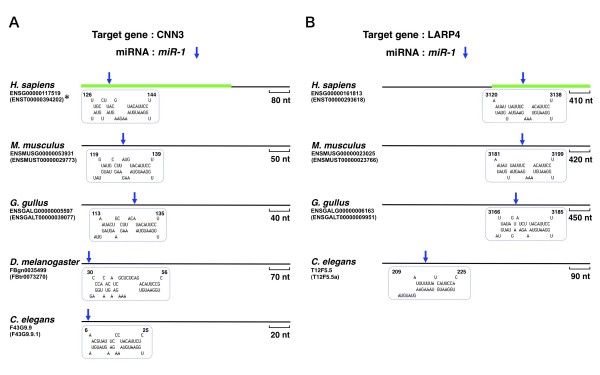
Two examples of miRNA target sites in orthologous gene transcripts. Potential target sites of miR-1 (blue arrows) in the 3'-UTR sequences of the orthologous CNN3 (A) and LARP4 (B) transcripts are shown. Predicted duplexes formed by the 3'-UTR sequences (top) and miRNAs (bottom) are shown in dotted boxes for each potential target site. The green bar on the H. sapiens 3'-UTR sequence indicates a DNA region used for the construction of the reporter plasmid pLuc-CNN3 (Figure 4A). See Additional file 3 for other candidates. (*) The length of the CNN3 3'-UTR is currently registered as a little shorter than that indicated (527 nt in size) and contains the miR-1 binding site (Ensembl release 53).